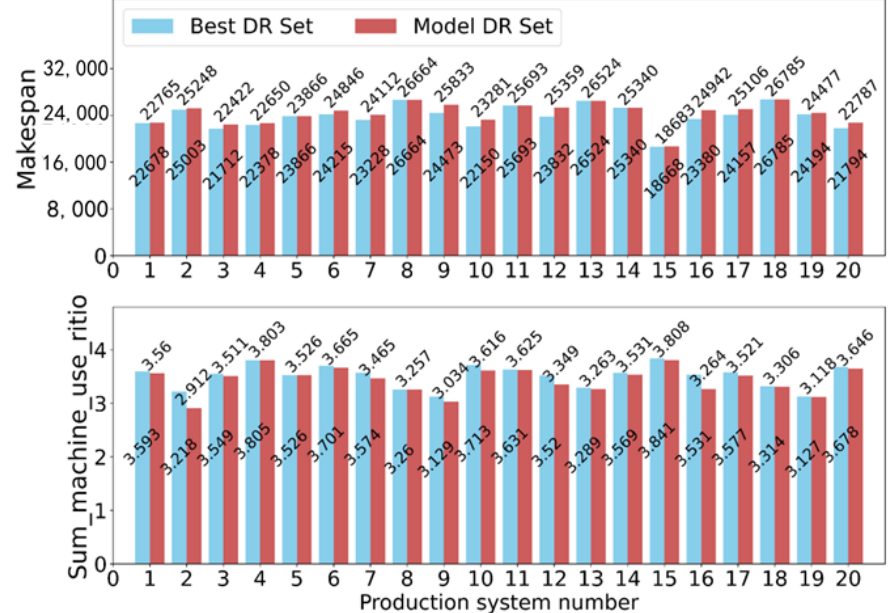
Figure 17 High job heterogeneity and a high manufacturing system load rate. Figure 17. High job heterogeneity and a high manufacturing system load Table 11. Statistics of the comparison between the decision model and optimal DR combination results.